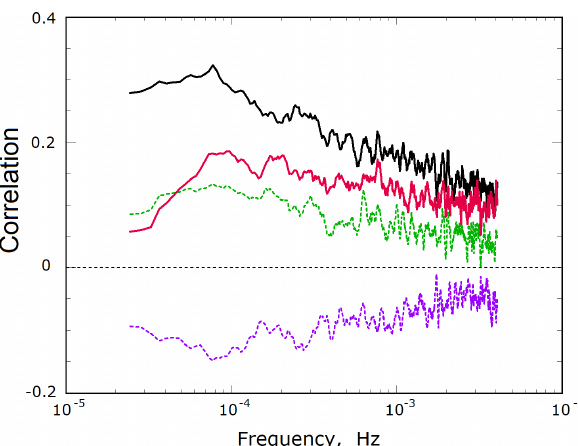
Figure 4. Correlation between radial (R) and normal (N) components of magnetic field ( blue line ) and velocity ( red line ) as functions